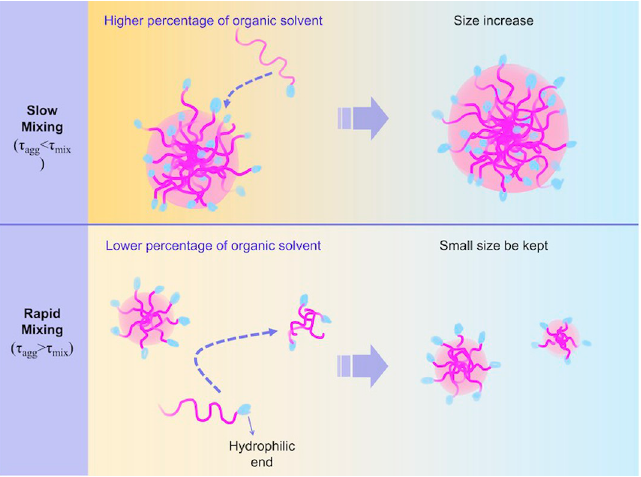
Fig 3. Mechanism of NP self-assembly during the solvent exchange. The relationship of the time scale of mixing and aggregation is the critical factor affecting the final particle size.